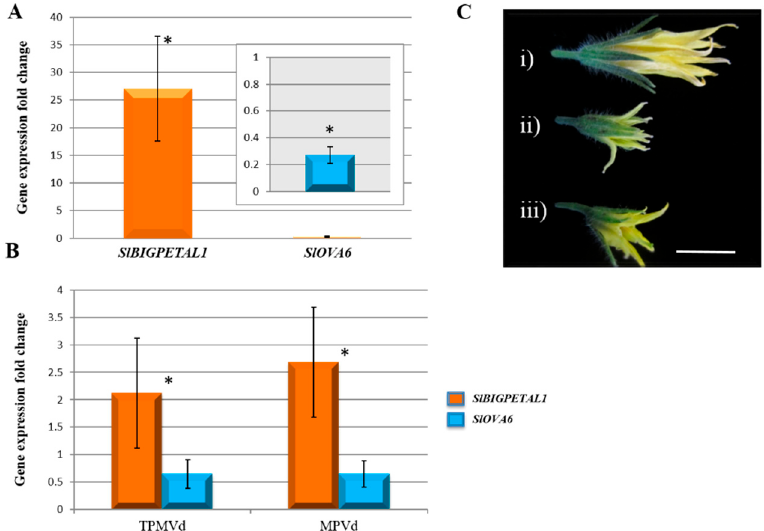
Figure 3. SlBIGPETAL1 and SlOVA6 flowering-related genes. SlBIGPETAL1 and SlOVA6 gene expression in flowers ( A ) compared to leaves ( B ) in TPMVd and MPVd viroid-infected flower tissue. ( C ) Comparative size of flowers (i) mock-inoculated, (ii) TPMVd and (iii) MPVd-infected flowers. Bar = 1 cm. Gene expression values are relative to mock-inoculated controls to which a value of 1 was assigned. The EF-1 α elongation factor gene was used as an internal reference. Error bars indicate two times the value of the standard deviation (SD) for the corresponding data set. Asterisks indicate statistical significance when analyzed using a paired t -test ( p < 0.05). Where both treatments are statistically significant from mock-inoculated controls, one asterisk is placed above the bars.